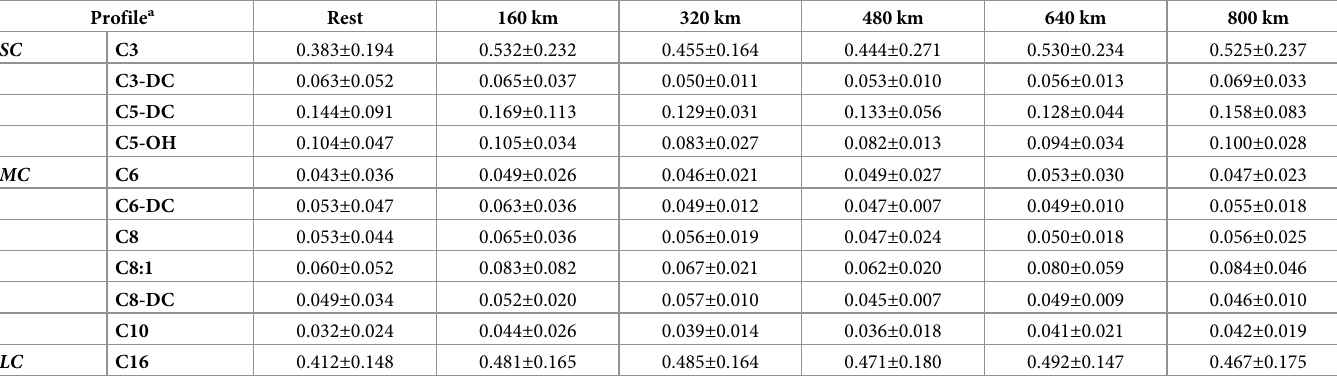
Table 1. Plasma concentrations ( μ mol/l) of short (SC), medium (MC) and long-chain (LC) acylcarnitines not significantly affected by multiday exercise. Profile a